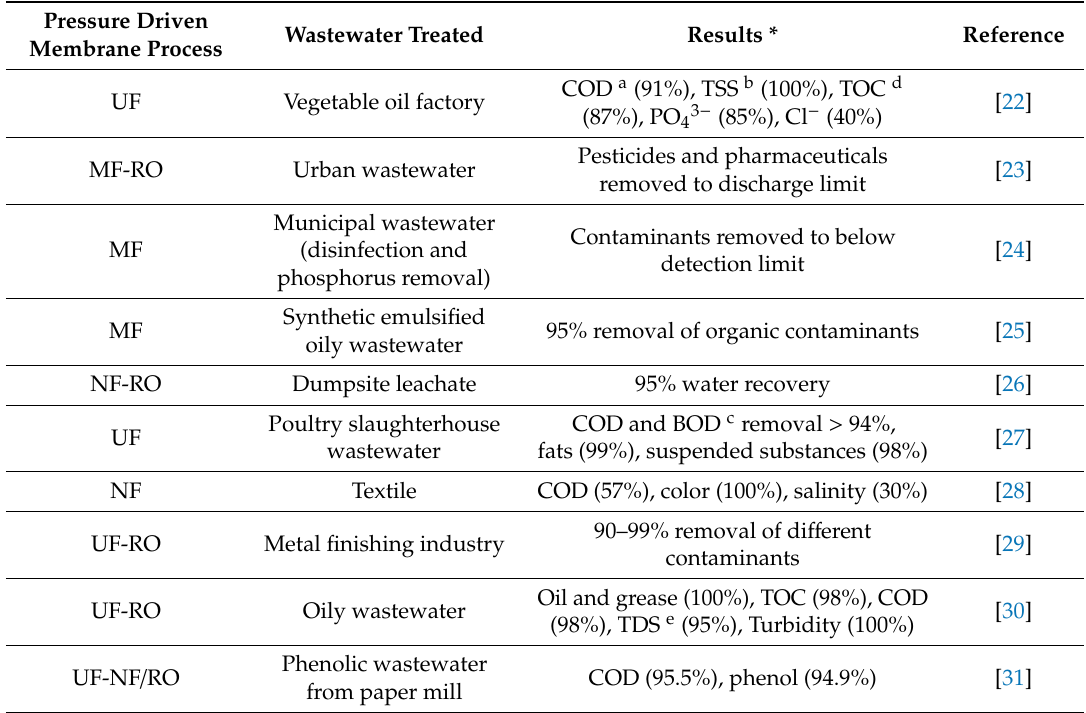
Table 2. Some applications of pressure driven membrane processes in wastewater